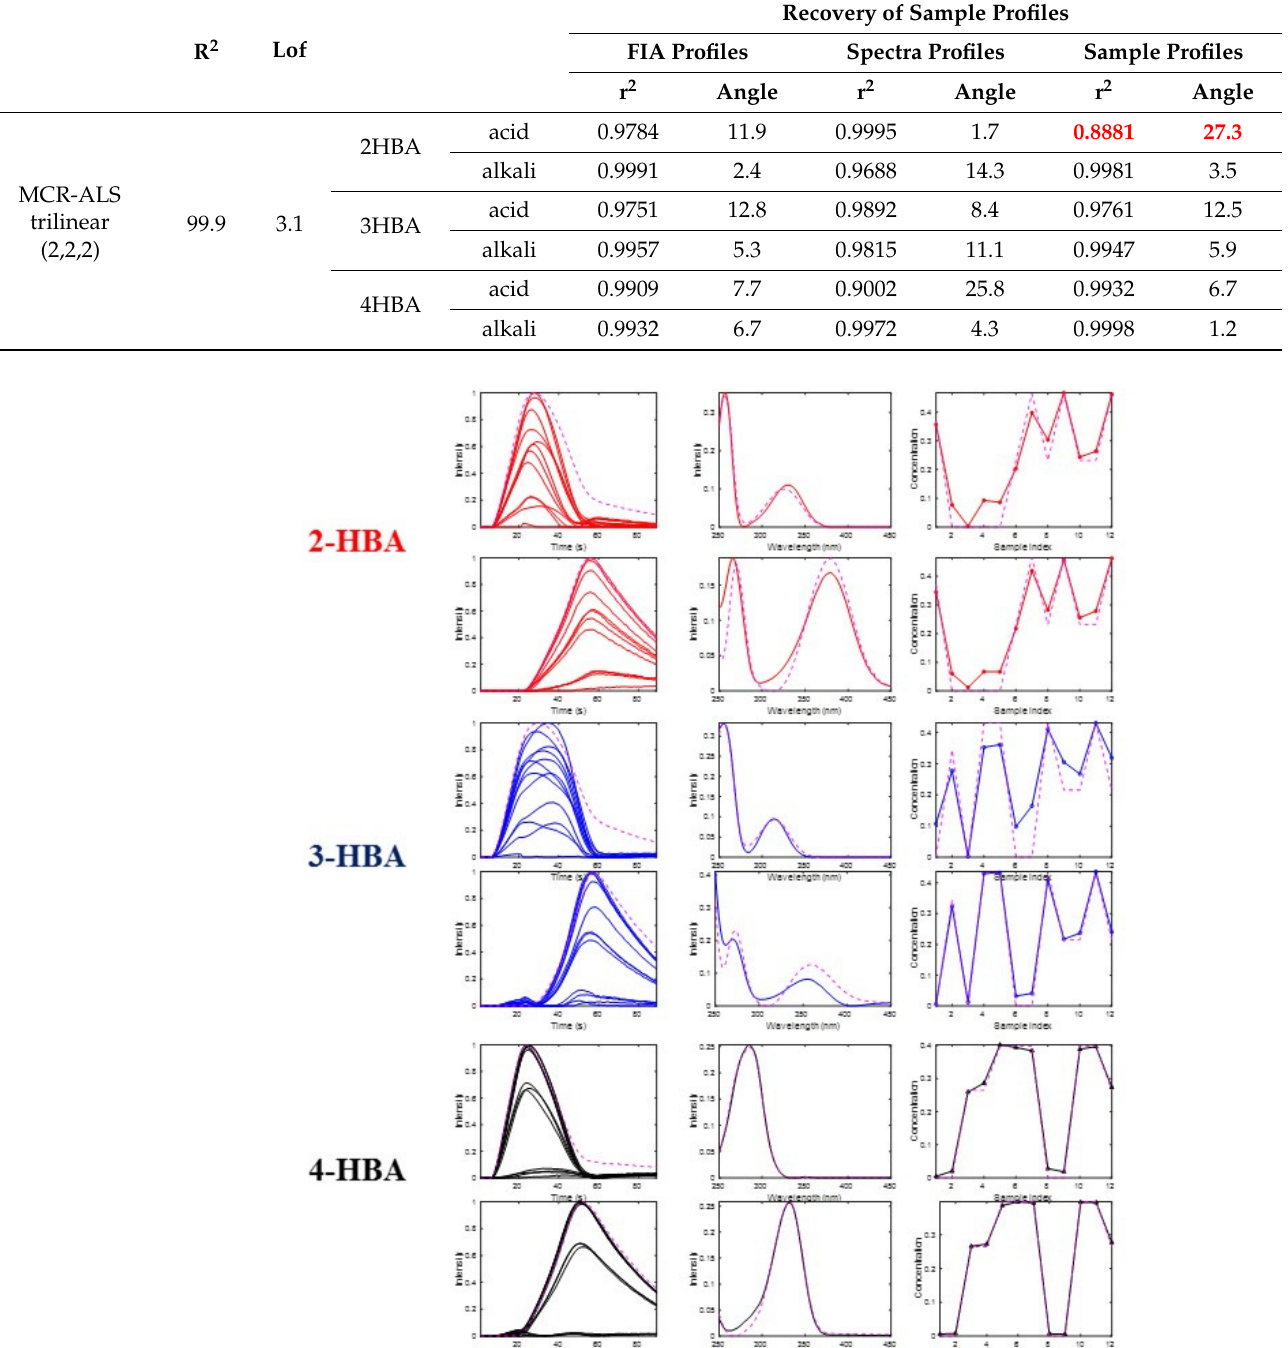
Figure 7. FIA (left), spectra (middle), and sample (right) profiles of the six components resolved in the analysis of the pH gradient FIA-UV dataset by MCR-ALS bilinear, corresponding to the two acid-base species of 2-HBA (red), 3-HBA (blue) and 4-HBA (black). Species spectra and sample profiles were compared with reference ones (cyan). See results in Section 4.3 and Table 3. Table 3. Comparison of results obtained by ATLD, PARAFAC, PARAFAC2, and different variants of MCR-ALS using six components in the analysis of the FIA dataset. In bold red, the worse recov- ered profiles with r 2 values below 0.9 are shown. See Equations (7)–(10) for the meaning of R 2 , lof, r 2 and angle. See end of Section 2.2 for the meaning of the different MCR-ALS variants.